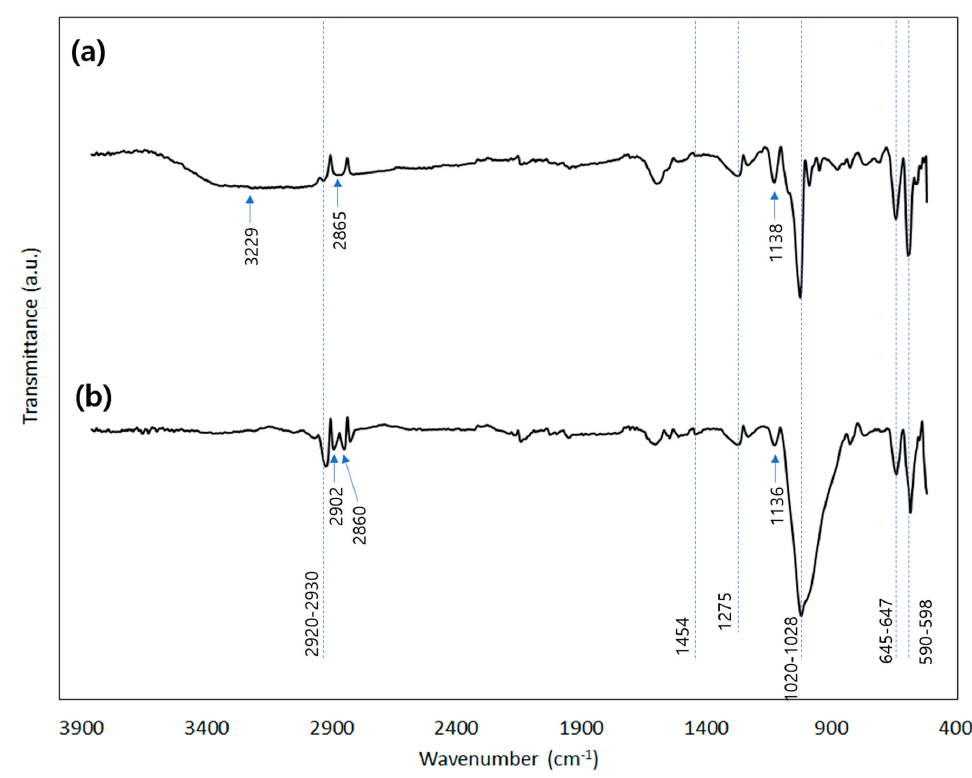
Figure 2. Fourier transform infrared spectroscopy spectra of Fe-CMB ( a ) before and ( b ) after Sb(V)